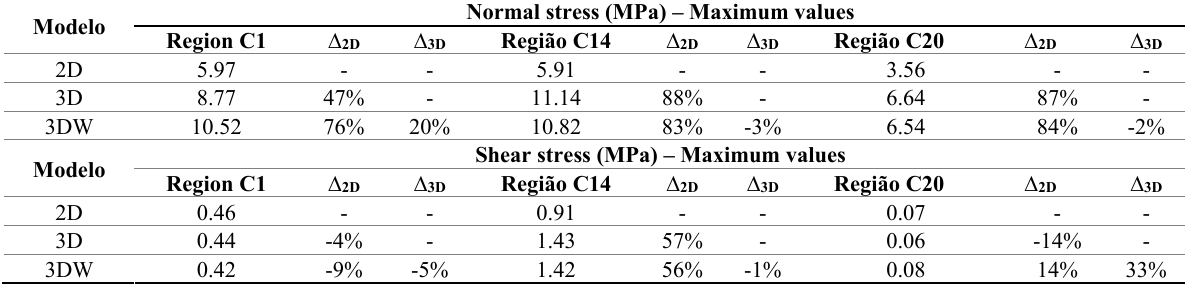
Table 5. Normal and shear stresses at the bottom of Wall